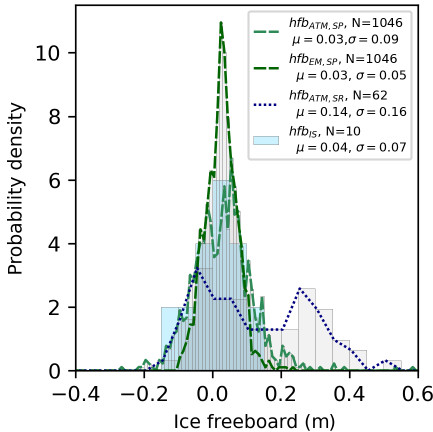
Figure 6. Probability density functions (PDFs) of ice freeboard (hi) with given average values ( µ ), standard deviations ( σ ) and num- ber of measurements ( N ) from the 2-D survey field site: hfb ATM , SP (light green dashes): freeboard calculated from SP snow depth and ATM surface elevations using Eq. (2); hfb EM , SP (dark green dashes): ice freeboard from EMs and SP measurements; hfb ATM , SR (dark blue dots): ice freeboard derived from ATM surface elevation minus matched SR snow depths within the 2-D field; hfb IS (light blue bars): ice freeboard from drill-hole observations on 2-D field edges, plotted as a regular histogram for tidy